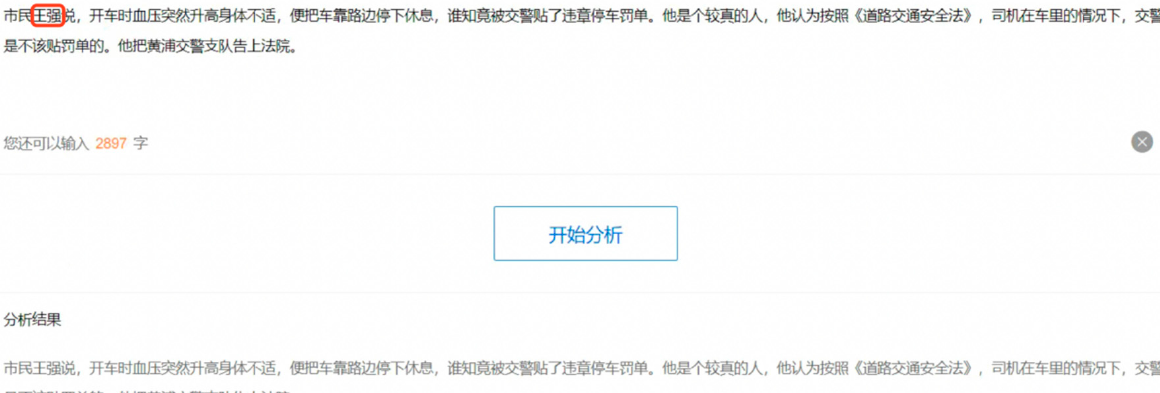
Figure 2. Example 2 of Baidu online text summarization results (input: Wang Qiang, a citizen, said that when he was driving, his blood pressure suddenly became high and his body was unwell, so he stopped his car by the roadside to have a rest. Unexpectedly, he was posted a parking ticket by